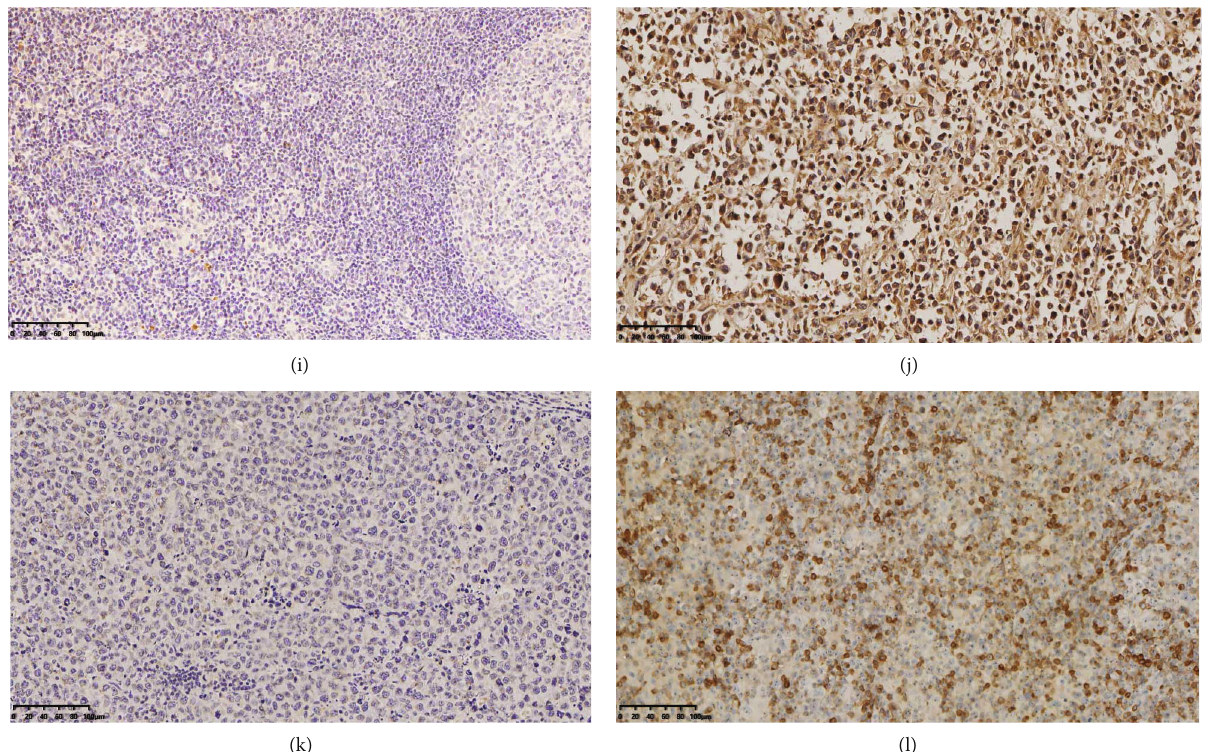
Figure 1: (a ~ l) Immunohistochemical results (EnVision method, original magni fi cation ∗ 200) of DLBCL. (a – l) Expressions of YWHAZ, AKT, BAD, BAX, p-AKT, and BCL-2 in DLBCL oncocytes. DLBCL: di ff use large B cell lymphoma. (a, c, e, g, i, k) The expressions of YWHAZ, AKT, BAD, BAX, p-AKT, and BCL-2 were of low-grade positive in the tumor cells, respectively. (b, d, f, h, j, l) The expressions of YWHAZ, AKT, BAD, BAX, p-AKT, and BCL-2 were of high-grade positive in the tumor cells,